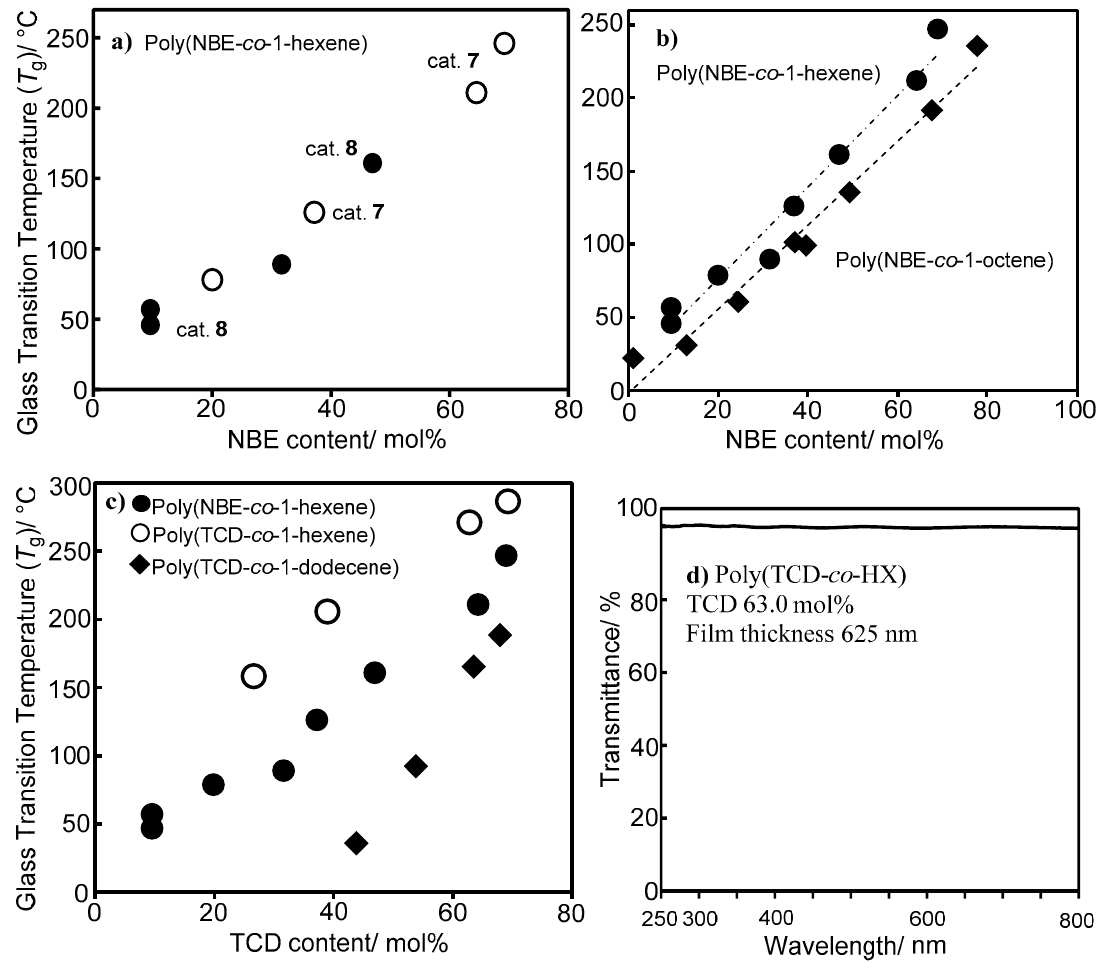
Figure 1. Plots of glass transition temperature ( T g ) vs NBE content (mol %) in ( a ) poly(NBE ‐ co ‐ 1 ‐ hexene)s by Cp’TiCl 2 (N=C t Bu 2 ) (Cp’ = Cp ( 7 , ○ ) or t BuC 5 H 4 ( 8 , ● )) ‐ MAO catalysts; ( b ) poly(NBE ‐ co ‐ 1 ‐ hexene)s (marked with ● ) and poly(NBE ‐ co ‐ 1 ‐ octene)s (marked with ♦ ); ( c ) plots of T g values vs TCD content (mol %) in poly(TCD ‐ co ‐ 1 ‐ hexene)s and poly(TCD ‐ co ‐ 1 ‐ dodecene)s; ( d ) plots of transmittance vs wavelength in poly(TCD ‐ co ‐ 1 ‐ hexene) [54]. Table 4. Copolymerization of tetracyclododecene (TCD) with 1-hexene (HX), 1-octene (OC), or 1-dodecene (DD) by CpTiCl 2 (N=C t Bu 2 ) ( 7 )-MAO catalyst a